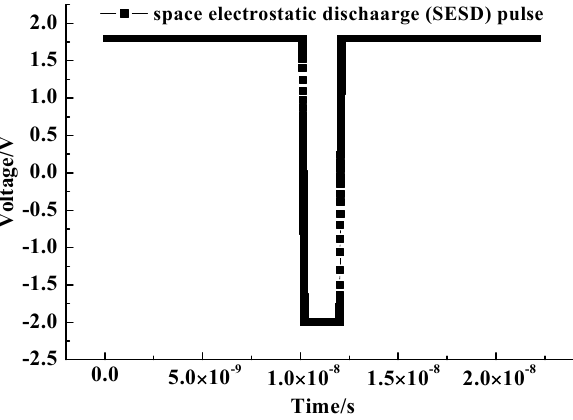
Figure 3. The characteristics of voltage pulse injected at the power supply node.